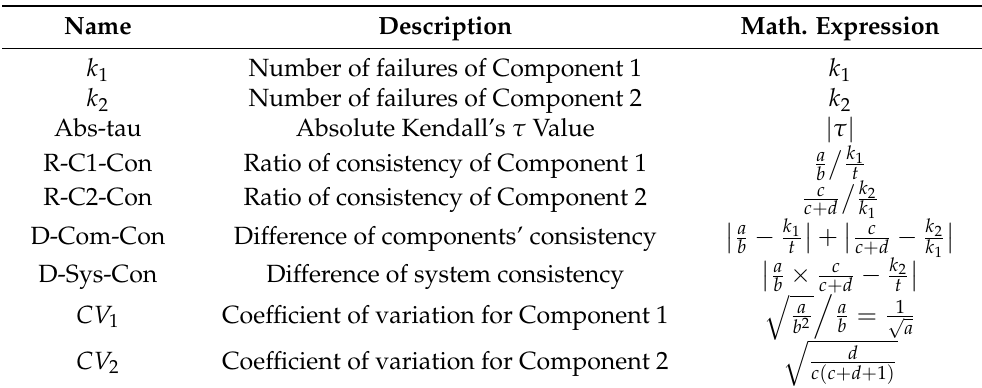
Table 5. Adjusted